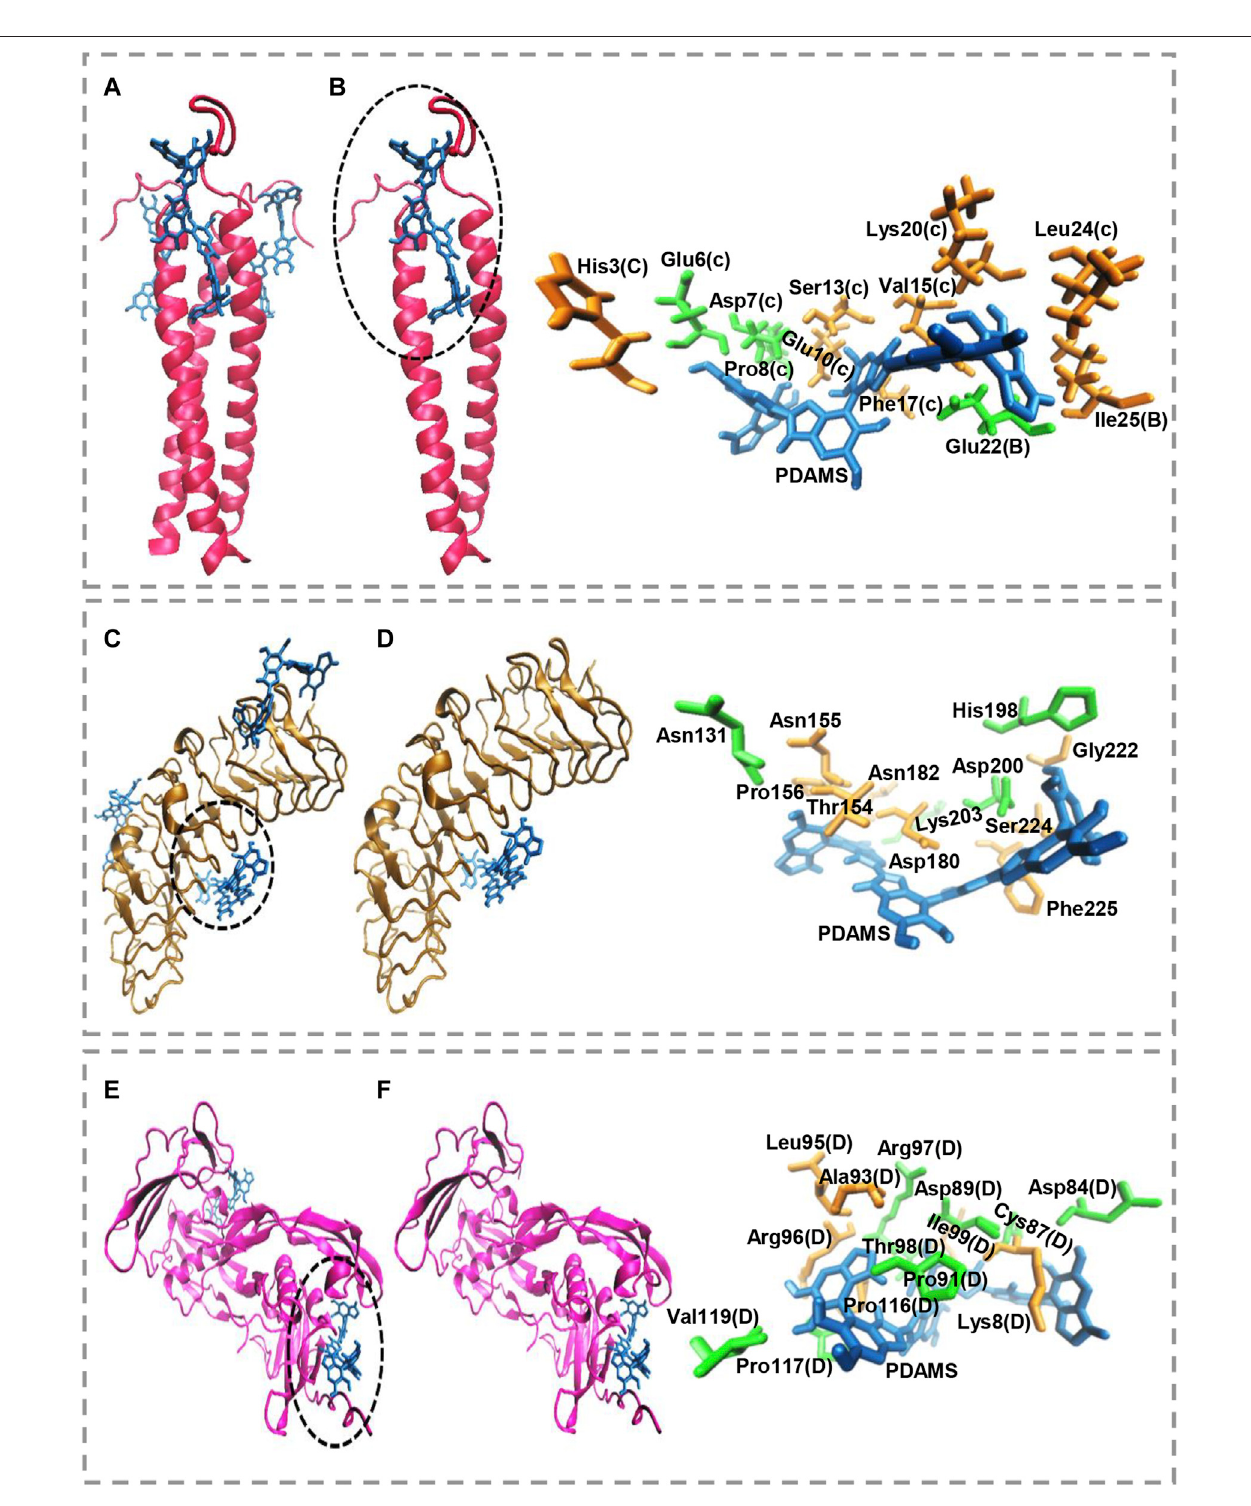
FIGURE3| MoleculardockingsimulationofPDAMSbindingtotargetproteins.ThePDAMSisshownaslicoriceinblueaswellasMatrilin-1,Decorin,andBMP2are shown as cartoon in red, ochre, and magenta, respectively. The main driving forces to form the target proteins-PDAMS complex are Van der Waals interaction and hydrogen bond. Vander Waalsinteraction and hydrogen bond areshown inorange and green, respectively (A) Matrilin-1interaction withPDAMS (B) PDAMSislocated betweentwo α -helixesofMatrilin-1attheheadofthecoiled-coil.ThebestmodeofPDAMSinteractionwithMatrilin-1inthebindingsite (C) Decorininteractionwith PDAMS (D) ThebestmodeofPDAMSbindingtoDecorinandthespeci fi cinteractionsinthebindingsite (E) BMP2interactionwithPDAMS (F) ThebestmodeofPDAMS interaction with BMP2 and the speci fi c interactions in the binding site.